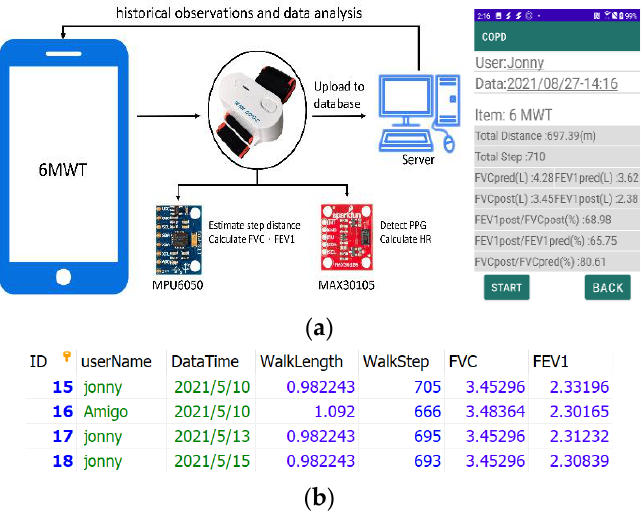
Figure 5. ( a ) The process chart (left) and home screen (right); ( b ) the 6MWT history (SQL).